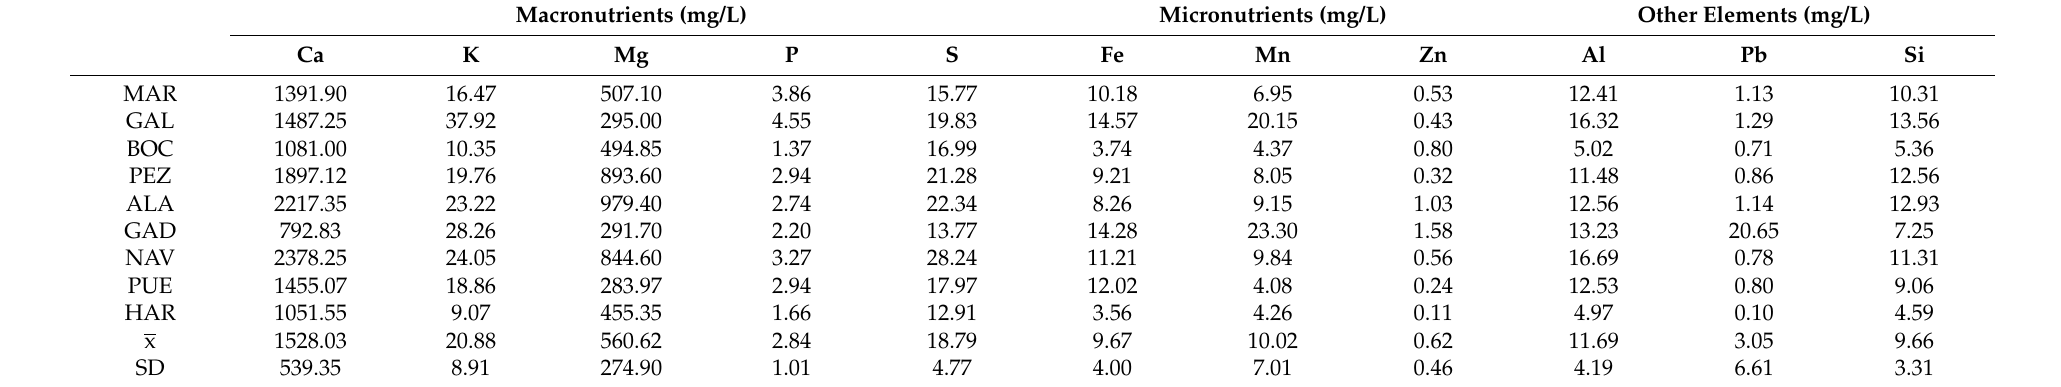
Table 3. Average value of macronutrients, micronutrients and other phytoavailable elements of interest concentrations (mg/L), total averages (x) and their standard deviations (SD) for each